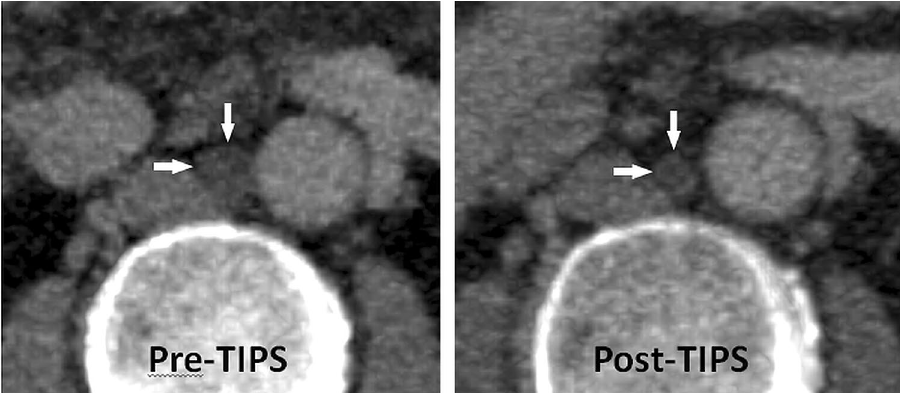
Figure 1. CT images of a patient before and after TIPS-creation demonstrating a considerable decrease in cisterna chyli (arrows) diameter after TIPS-creation.